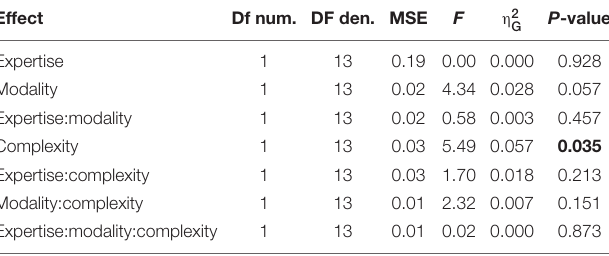
TABLE 4 | Repeated measure ANOVA—synchronization accuracy (experiment 2).